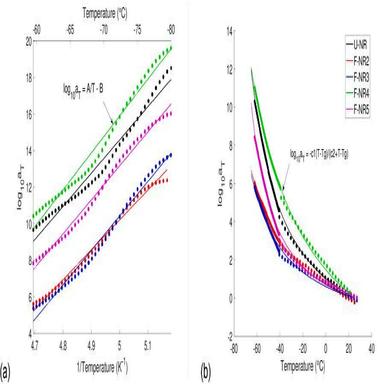
Comparisons of the shift factors used to construct the master curve for F-NRs (a) below Tg and (b) above Tg.